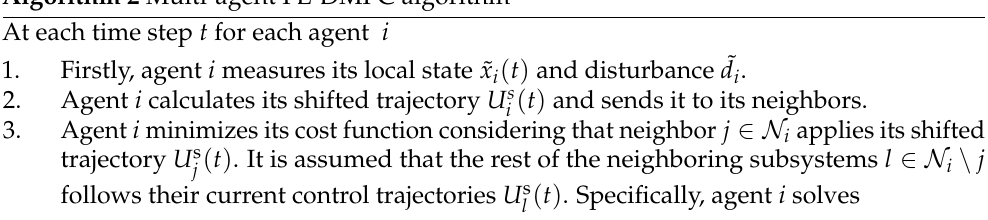
Algorithm 2 Multi-agent FL-DMPC